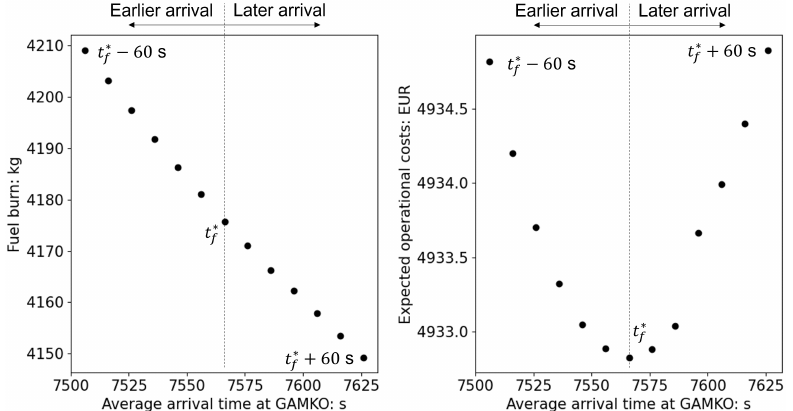
Figure 13. ( Left ) Trend of the average arrival time at GAMKO vs. fuel burn: ± 60 s from the average arrival time without RTA t ∗ average arrival time at GAMKO vs. the robust operational costs J robust (Equation (37)) with the same RTA